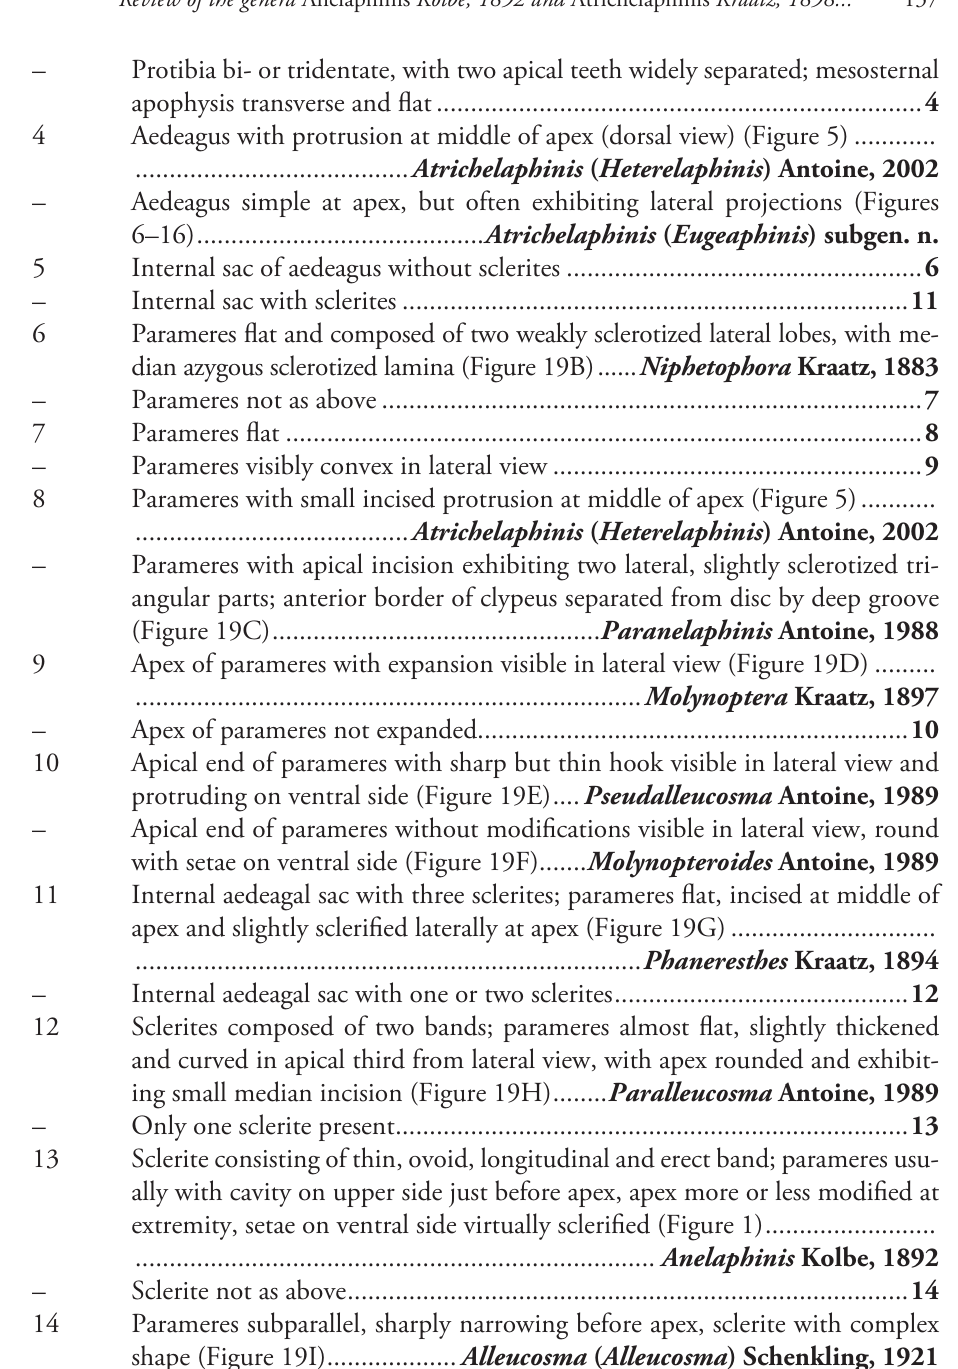
– Protibia bi- or tridentate, with two apical teeth widely separated; mesosternal apophysis transverse and flat ....................................................................... 4 4 Aedeagus with protrusion at middle of apex (dorsal view) (Figure 5) ............ – Aedeagus simple at apex, but often exhibiting lateral projections (Figures 5 – 6 Parameres flat and composed of two weakly sclerotized lateral lobes, with me- dian azygous sclerotized lamina (Figure 19B) ...... Niphetophora Kraatz, 1883 – 7 – 8 Parameres with small incised protrusion at middle of apex (Figure 5) ........... – Parameres with apical incision exhibiting two lateral, slightly sclerotized tri- angular parts; anterior border of clypeus separated from disc by deep groove (Figure 19C) ................................................ Paranelaphinis Antoine, 1988 9 Apex of parameres with expansion visible in lateral view (Figure 19D) ......... – Apex of parameres not expanded............................................................... 10 10 Apical end of parameres with sharp but thin hook visible in lateral view and protruding on ventral side (Figure 19E) .... Pseudalleucosma Antoine, 1989 – Apical end of parameres without modifications visible in lateral view, round with setae on ventral side (Figure 19F)....... Molynopteroides Antoine, 1989 11 Internal aedeagal sac with three sclerites; parameres flat, incised at middle of apex and slightly sclerified laterally at apex (Figure 19G) .............................. – Internal aedeagal sac with one or two sclerites ........................................... 12 12 Sclerites composed of two bands; parameres almost flat, slightly thickened and curved in apical third from lateral view, with apex rounded and exhibit- ing small median incision (Figure 19H) ........ Paralleucosma Antoine, 1989 – Only one sclerite present ........................................................................... 13 13 Sclerite consisting of thin, ovoid, longitudinal and erect band; parameres usu- ally with cavity on upper side just before apex, apex more or less modified at extremity, setae on ventral side virtually sclerified (Figure 1) ......................... ............................................................................ Anelaphinis Kolbe, 1892 – Sclerite not as above .................................................................................. 14 14 Parameres subparallel, sharply narrowing before apex, sclerite with complex shape (Figure 19I) ................... Alleucosma ( Alleucosma ) Schenkling, 1921 – Parameres triangular, regularly narrowing from base to upturned apex; scler- ite small, oval or flat but not with complex shape (Figure 19J)